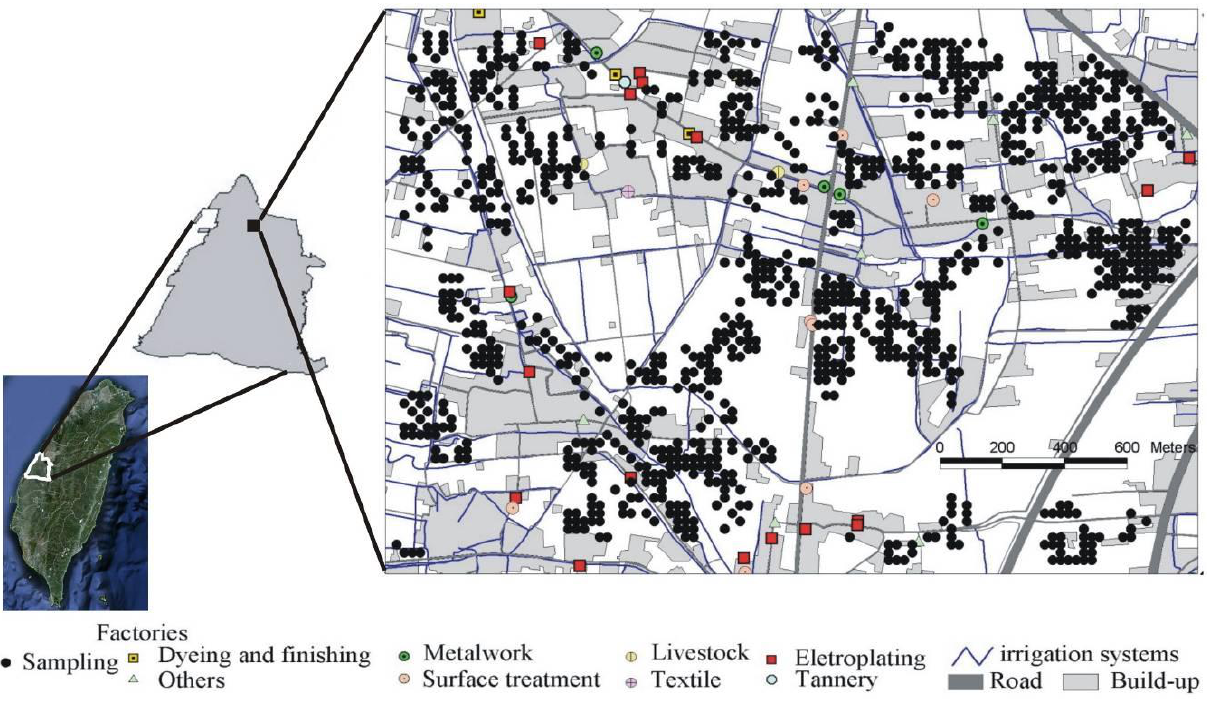
Figure 1. The study area and sampling